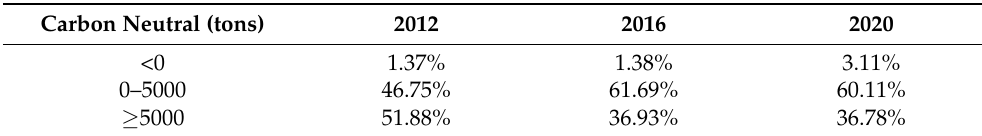
Figure 4. Temporal and spatial variation of carbon sink in Qinling Mountains. Table 3. Classification statistics of carbon